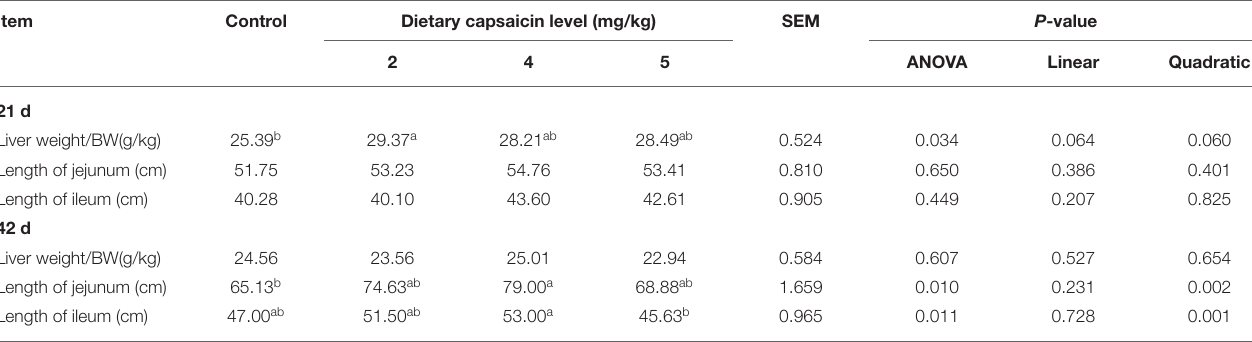
TABLE 7 | Effects of different levels of capsaicin on the liver index and the length of the small intestine of broilers.